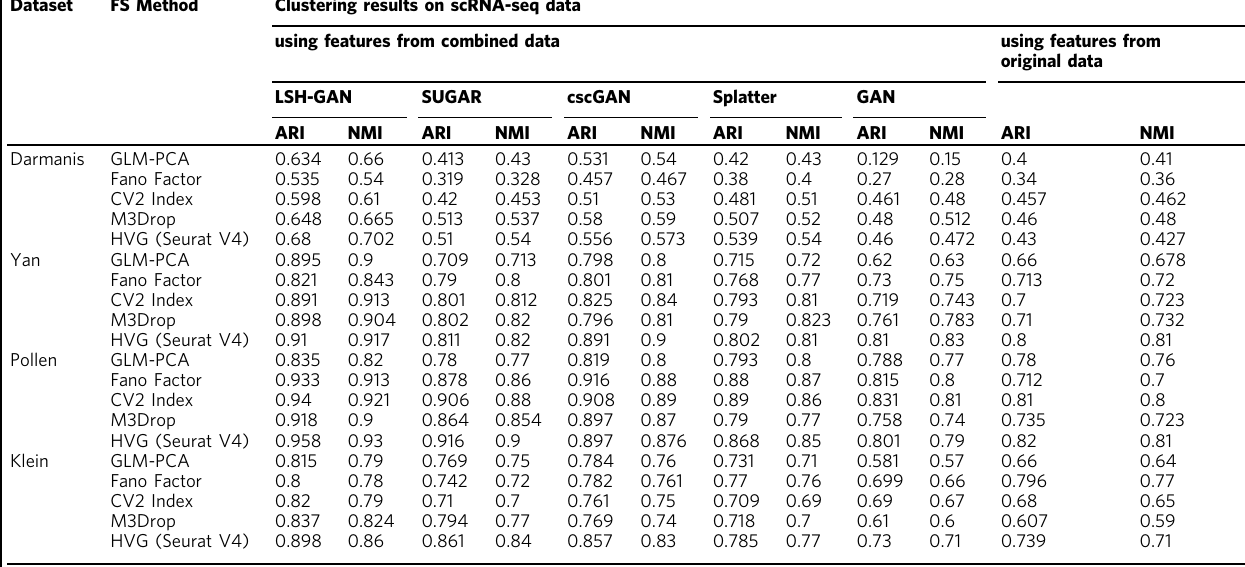
for Yan and Pollen datasets (see Supplementary Note 3 and Supplementary Fig. 1 for the results of the other two datasets). Figure 4b represents heatmaps of cell × cell consensus matrix. Each heatmap signi fi es the number of times a pair of cells is appearing in the same cluster 32 . Here two cells are said to be in different clusters if the score is zero (blue color). Similarly, a score ‘ 1 ’ (red) signi fi es two cells that belong to the same class. Thus completely red diagonals and blue off-diagonals represent a perfect clustering. A careful notice on Fig. 4a and b reveals a perfect match between the original and predicted labels for YAN and Pollen